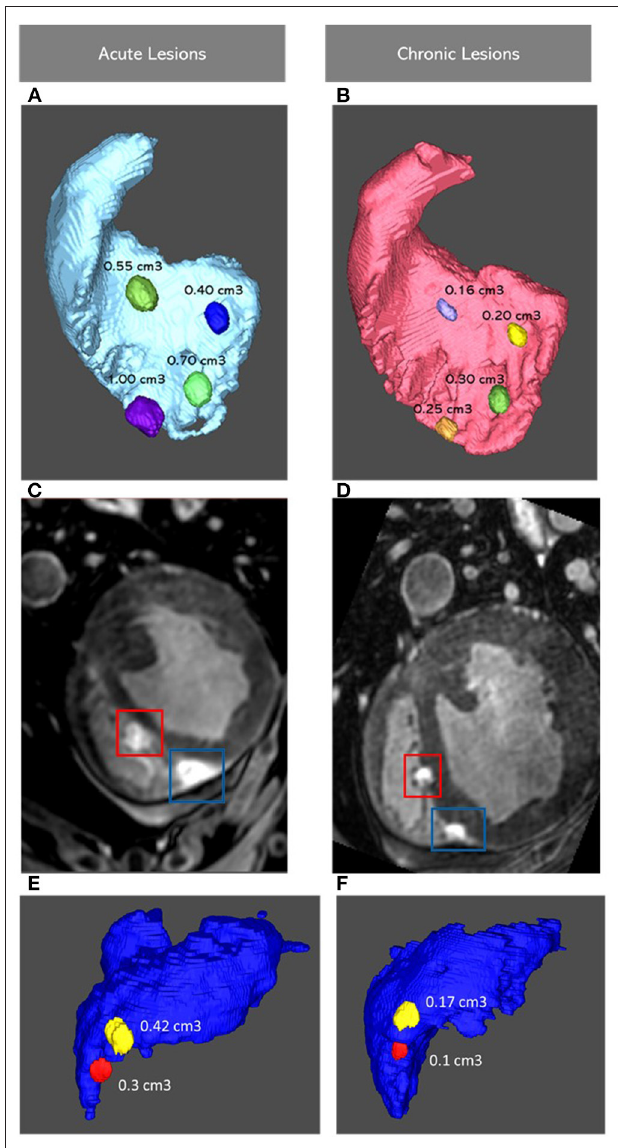
FIGURE 2 | Images Showing four Lesions Represented on Corview in the RV Septum in the Acute (A) and Chronic (B) Settings, with corresponding LGE-MRI Images of the Lower Two Lesions (C,D) . Images Showing two Lesions in The RV Free Wall (E,F) . RV: Right Ventricle; LGE-MRI: Late Gadolinium Enhancement Magnetic Resonance